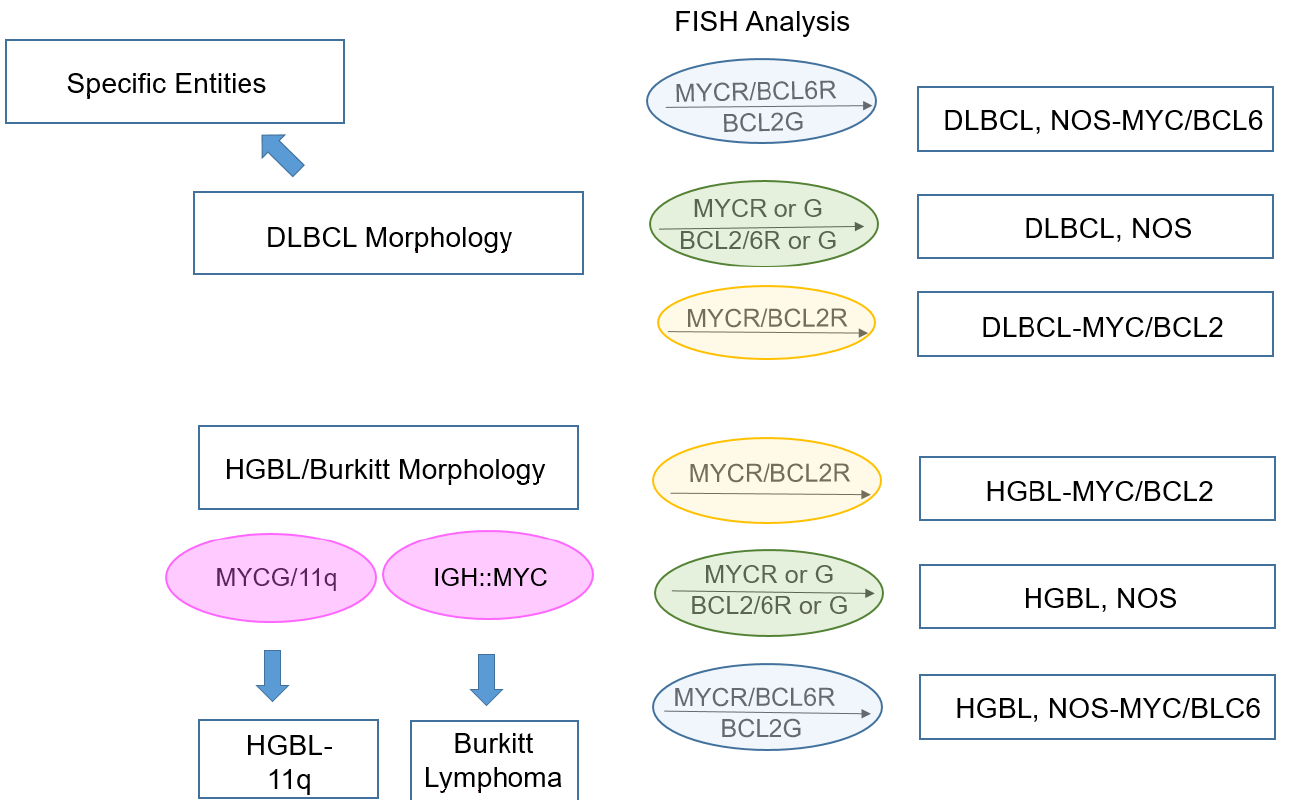
Figure 4. Algorithm for the classification of aggressive B-cell lymphomas in WHO-HAEM5 according to rearrangements of MYC , BCL2 , and BCL6 and/or presence of the complex 11q gain/loss pat- terns.